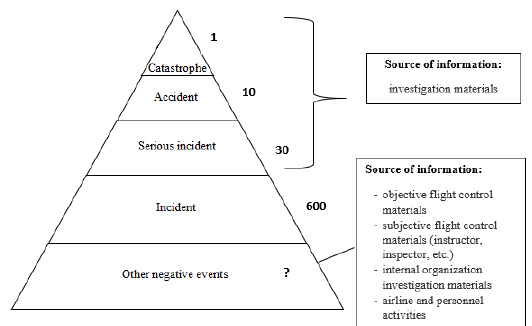
Figure 1. ICAO event pyramid supplemented (ISO,